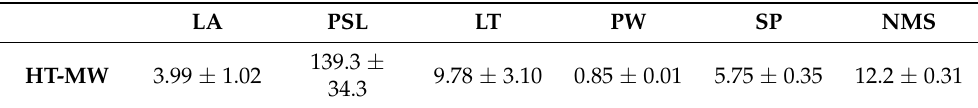
Table 2. Mean values of several vegetative growth components of the different treatments. LA (leaf area, m 2 vine − 1 ), PSL (primary shoot length, cm), LT (lateral shoots per vine, lateral shoots vine − 1 ), PW (pruning weight, kg vine − 1 ), SP (number of spurs per vine, spurs vine − 1 ), and NMS (number of main shoots per vine, shoots vine − 1